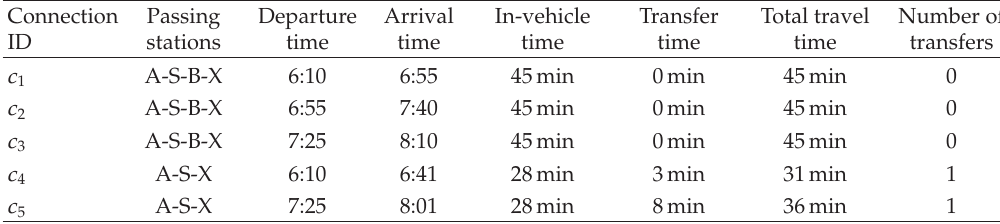
Table 1: Connections of example schedule-based transit